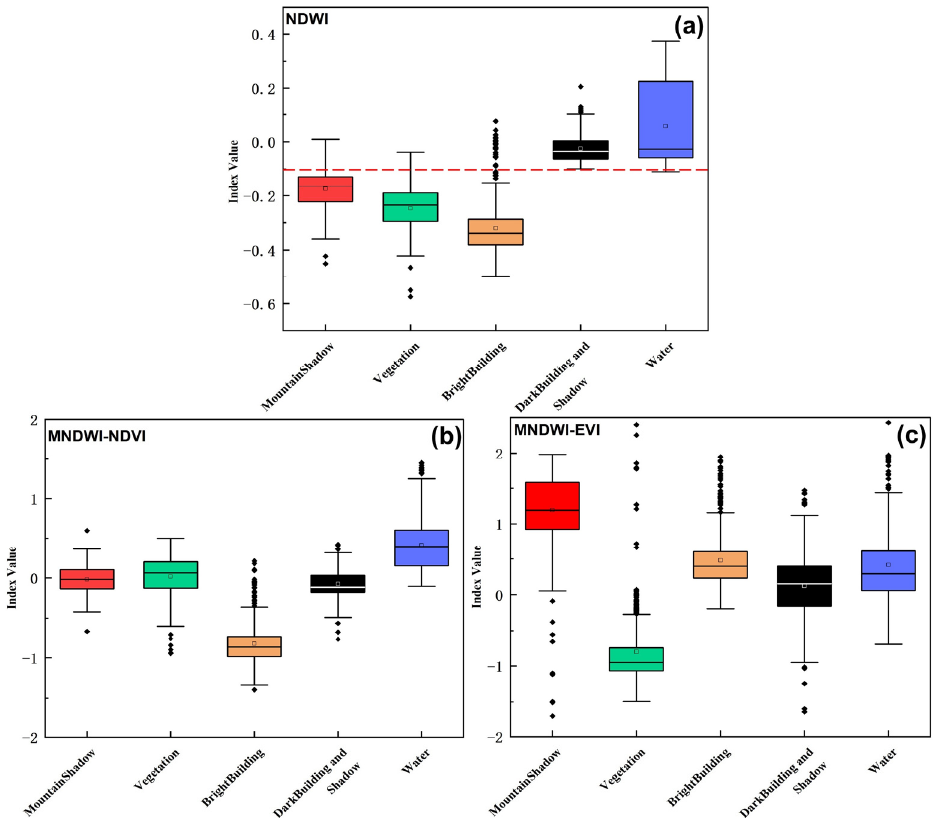
Figure 4. The box plot of five types of pixel index values for mountain shadows, vegetation, bright buildings, dark buildings and shadows, and water. ( a ) NDWI. ( b ) MNDWI-NDVI. ( c )